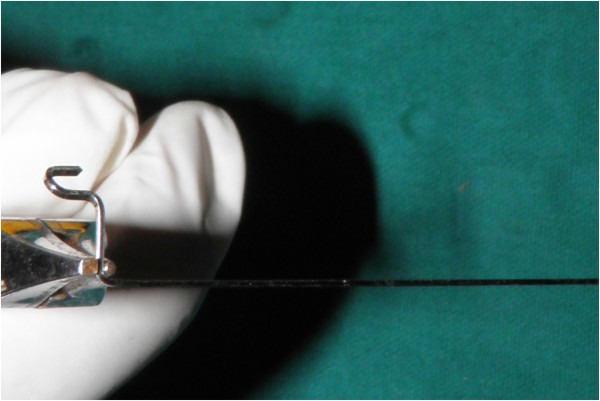
A ‘L’ bend is given.